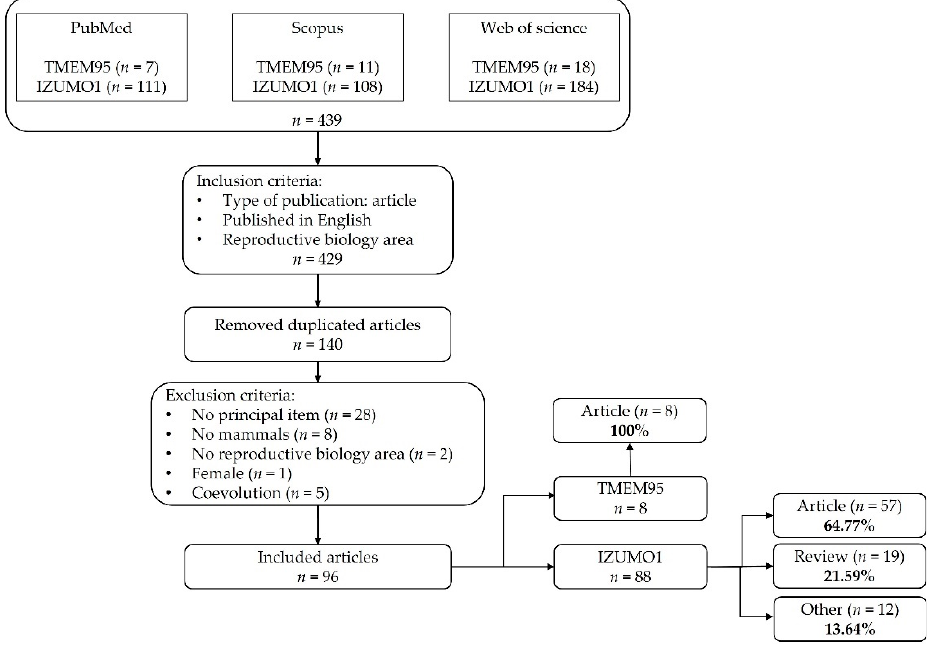
Figure 1. Flowchart summarizing the selection process of the articles included in the present review regarding IZUMO1 and TMEM95. Adapted from PRISMA Group [27].